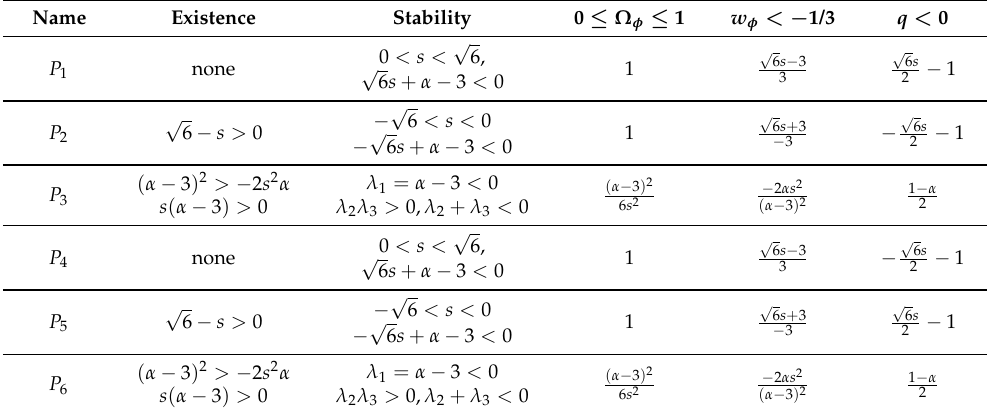
Table 1. The existence and stability conditions for six critical points; the cosmological quantities in the form of parameters s and α at each critical